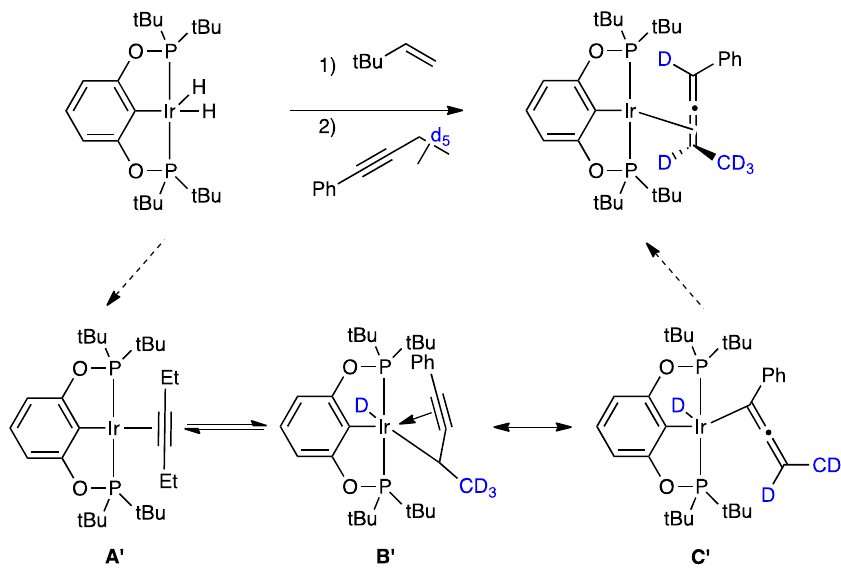
Scheme 1. Proposed mechanism of isomerization of internal alkyne to disubstituted allene product, shown for 1a – d5 → 1b – d5 .